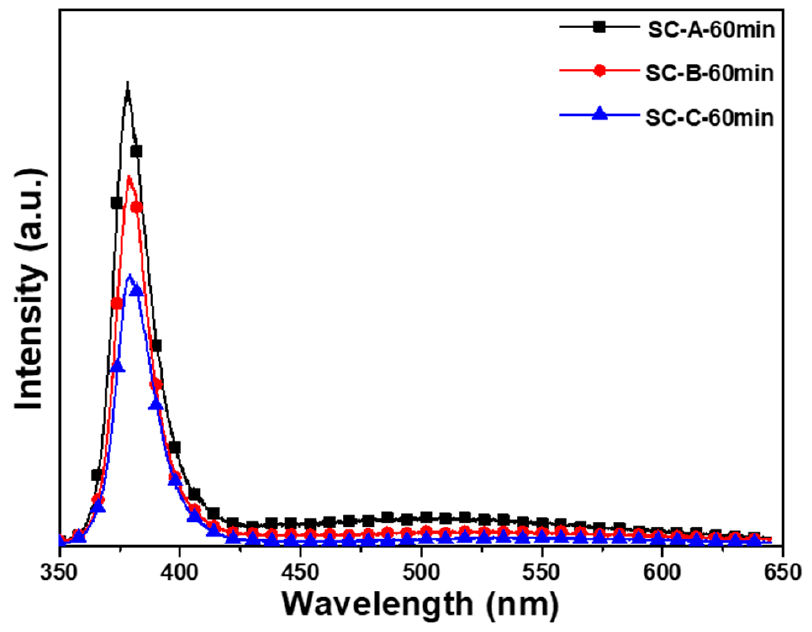
Figure 10. The PL spectra of the ZnO nanoflower arrays with a synthesis time of 60 min on different substrates.